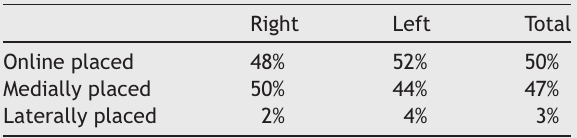
Right and left FRs positions in relation to base of lateral pterygoid plate.